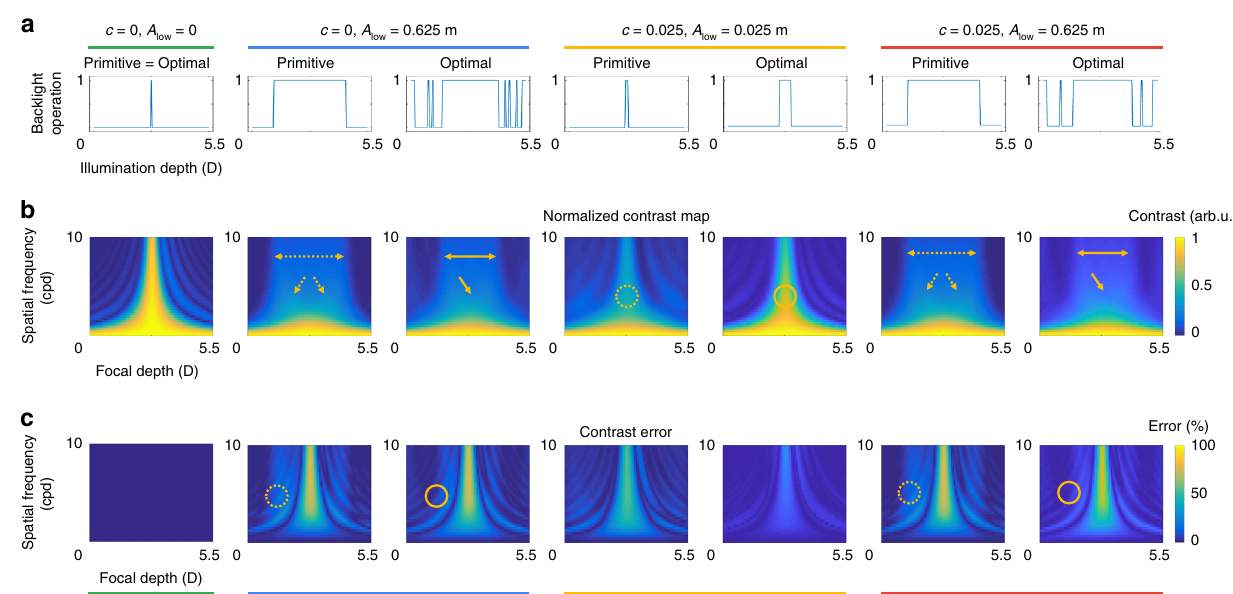
Fig. 6 Description of optimal illumination strategy. We simulate different conditions according to the degree of offset luminance and desired brightness: ( c ¼ 0, A 0), ( c ¼ 0, A 0 : 625 m ), ( c ¼ 0 : 025, A 0 : 025 m ), and ( c ¼ 0 : 025, A 0 : 625 m ). a We show the backlight operations according low ¼ low ¼ low ¼ low ¼ to the strategies and circumstances. b We demonstrate normalized contrast maps that are achieved by applying a corresponding backlight operation. Normalized contrast maps indicate the relative intensity of retinal images according to the spatial frequency and focal depths. c We provide contrast errors determined by the difference between the target and the reconstructed contrast maps. The differences between primitive and optimal strategies are highlighted by dotted or solid arrows and circles. An optimal illumination strategy allows more de fi nite and precise contrast curves. Note that our prototype supposes the third circumstance: ( c ¼ 0 : 025, A 0 : 025 m ). Additional results are available in Supplementary Note low ¼